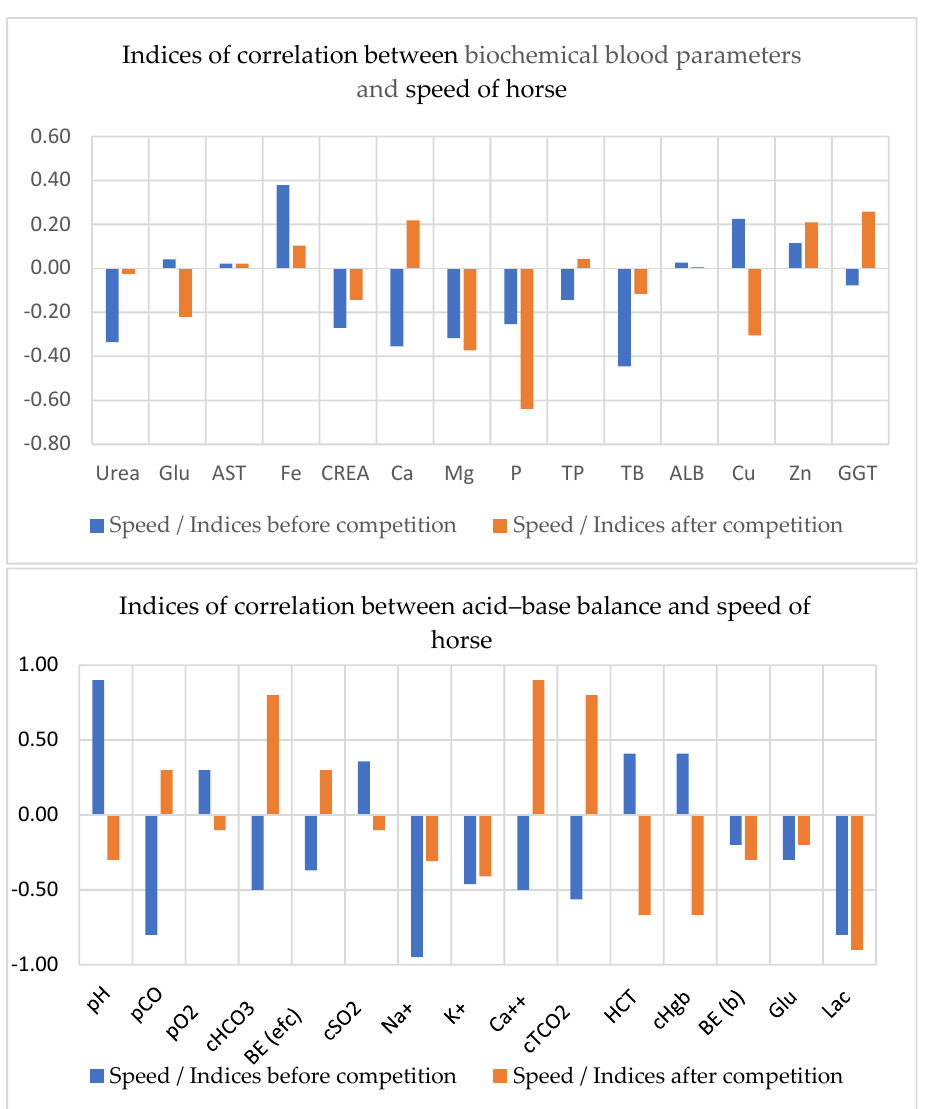
Figure 2. Correlations between blood indices and the speed of the Žemaitukai horses. pH—hydrogen potential; pCO 2 —partial carbon dioxide pressure; pO 2 —partial oxygen pressure; BE—base excess in the blood; BE (efc)—base excess in the extracellular fluid; HCO 3 —bicarbonate; cSO 2 —oxygen saturation; tCO 2 —total carbon dioxide in the blood; HCT—hematocrit; Hgb—hemoglobin concentration; Glu—glucose; Na + —sodium; K + —potassium; Ca ++ —ionized calcium; Lac—lactate; Urea—serum urea; Glu—glucose; AST—aspartate aminotransferase; Fe—iron; CREA—creatinine; Ca—total calcium; Mg—magnesium; p —phosphorus; TP—total protein; TB—total bilirubin; ALB—albumin; Cu—cuprum; Zn—zinc; GGT—gamma ‐ glutamyl transferase.